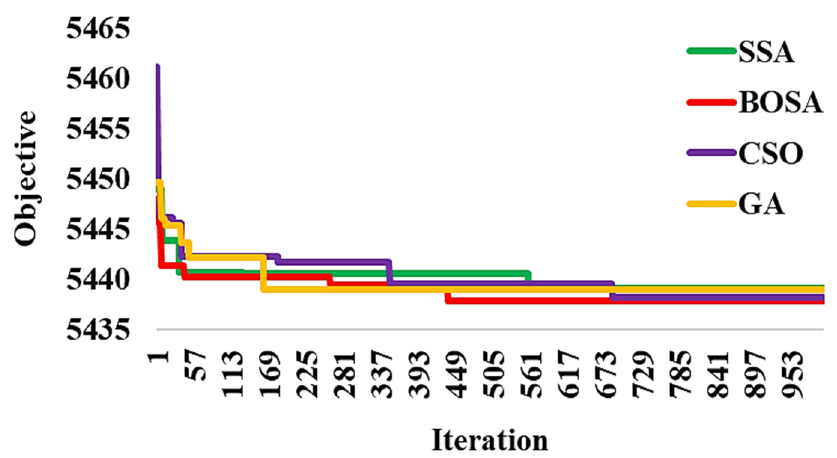
Figure 11. Convergence curves for BOSA, SSA, CSOA, and GA.